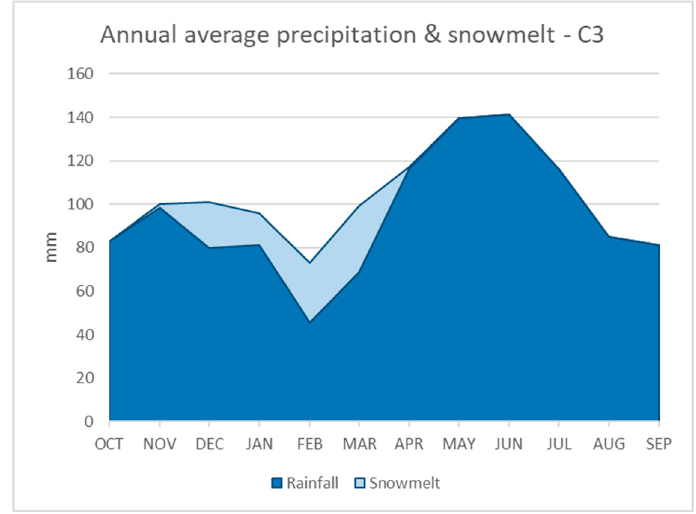
Figure 7. Annual average precipitation and snowmelt (in mm) for the three configuration periods.